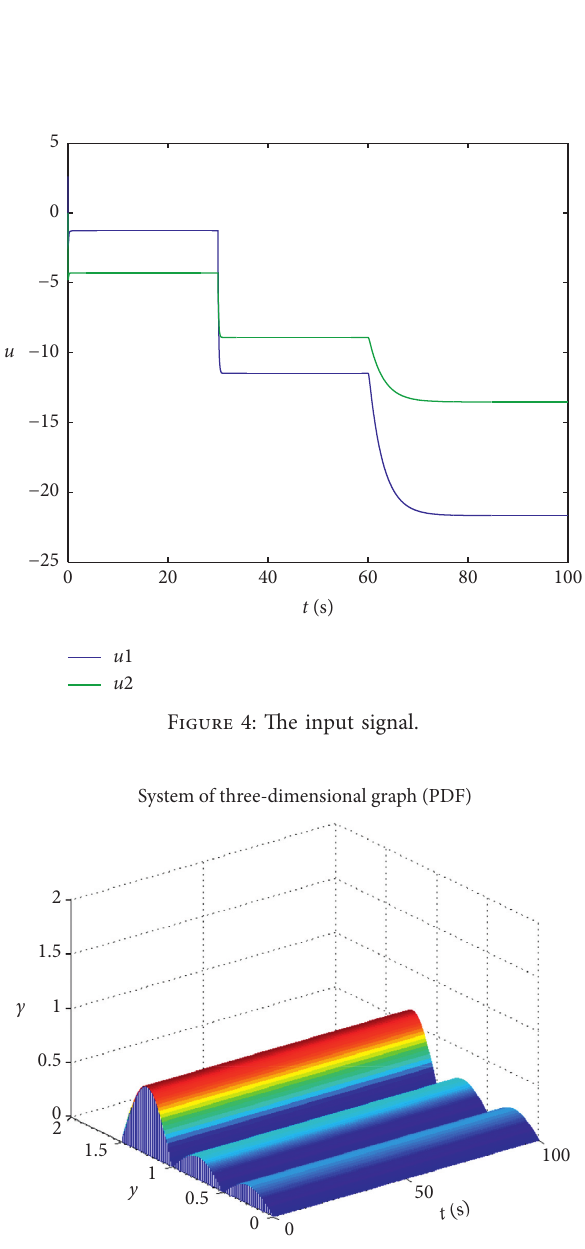
Figure 5: The desired output PDF.